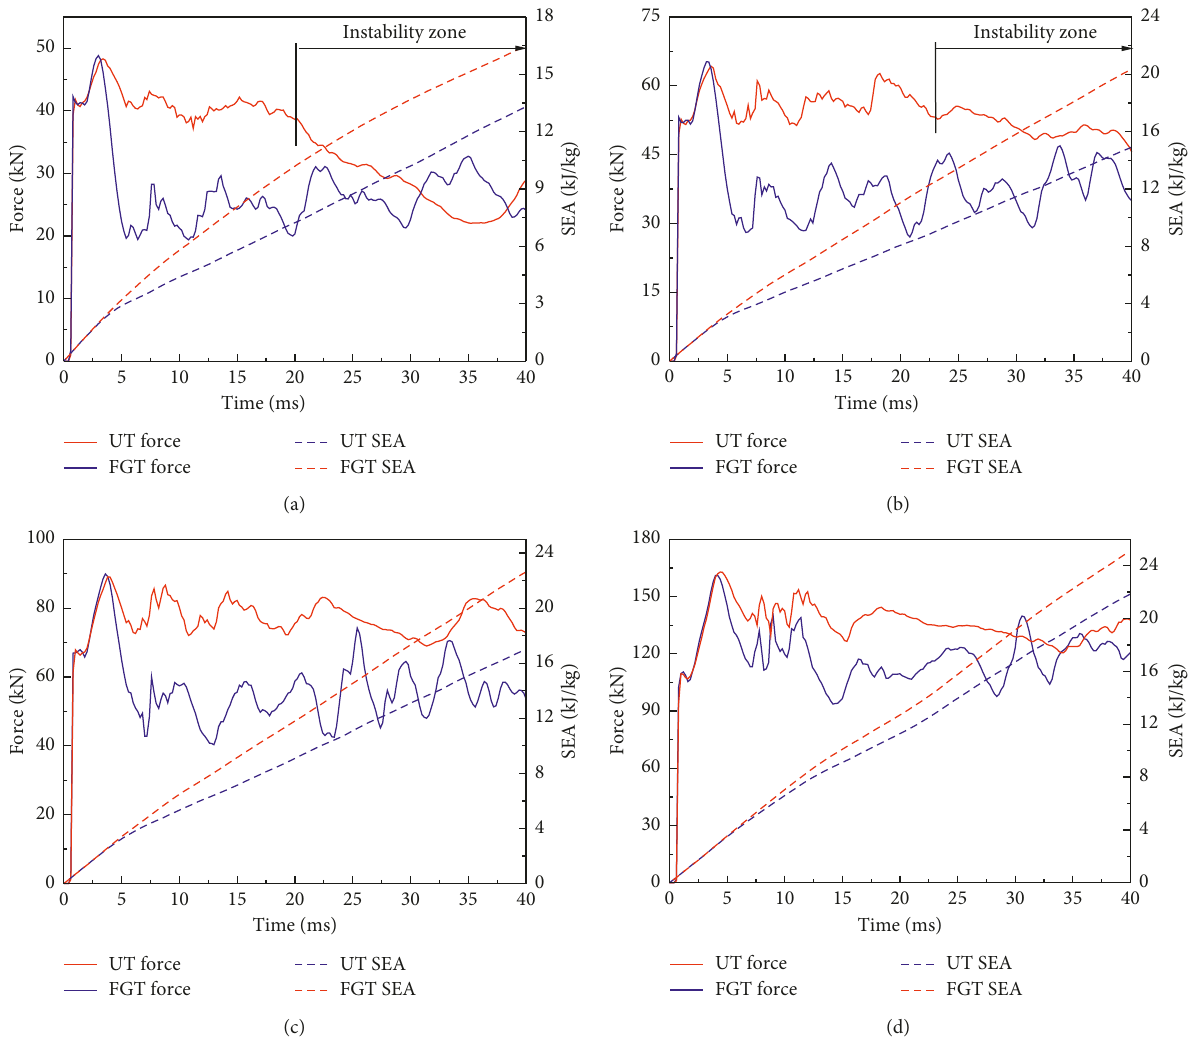
Figure 12: Comparison of crushing force and energy absorption of UTand FGT honeycomb structures with 22 cells. (a) SEA �